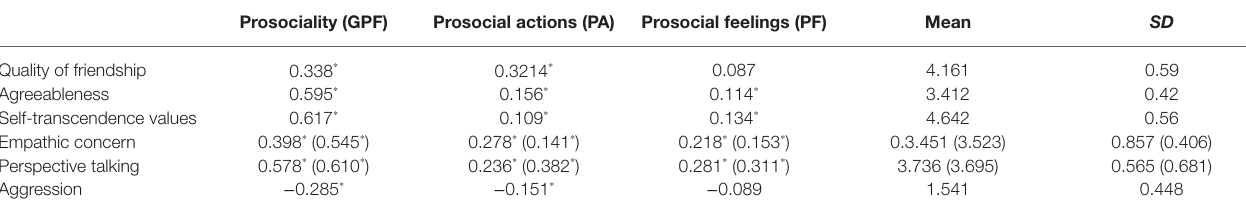
TABLE 3 | Descriptive statistics and correlations among the factors of the Prosociality Scale and indicators of (Mal) adjustment. Prosociality (GPF) Prosocial actions (PA) Prosocial feelings (PF) Mean SD Quality of